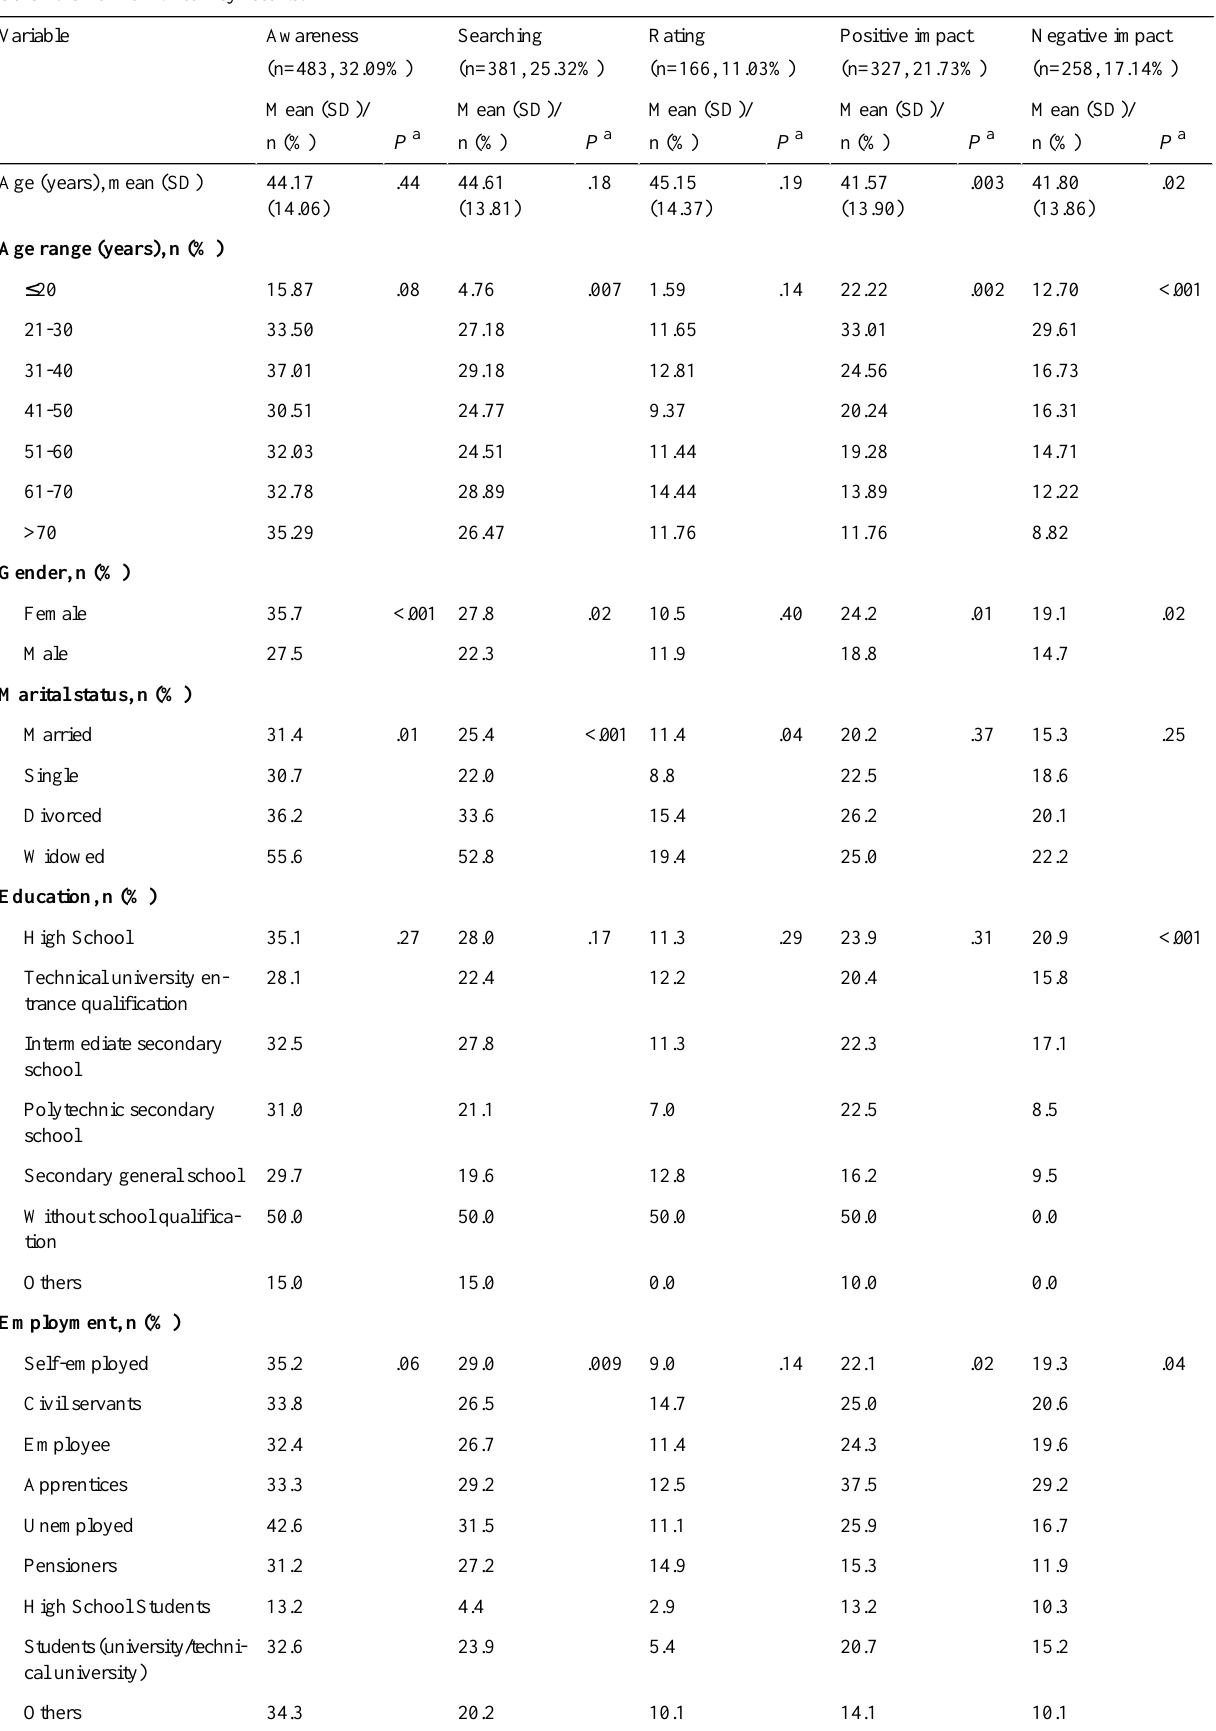
Table 2. Overview of survey results.